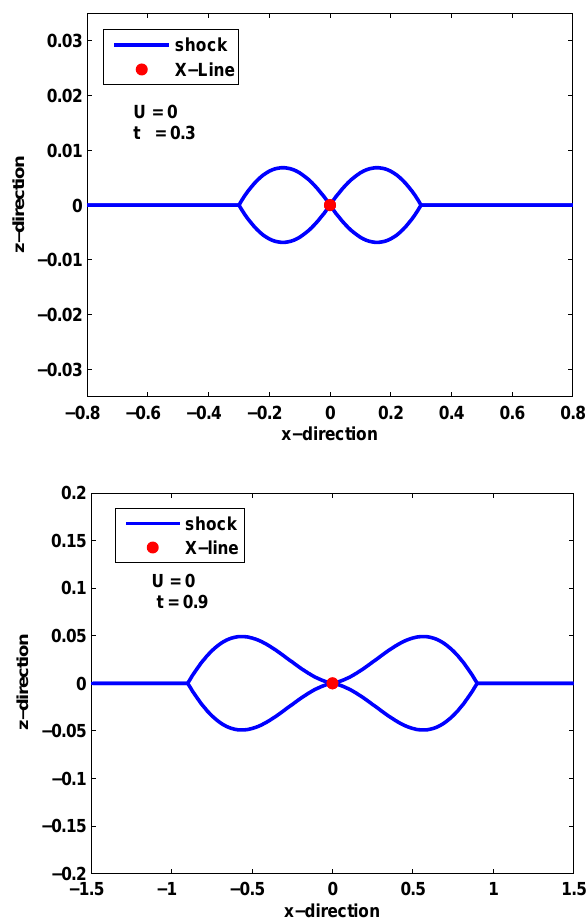
Fig. 2. Structure of the field reversal region during active recon- nection (switch-on phase) for the times t = 0 . 3 (upper panel) and t = 0 . 9 (lower panel) and velocity of the reconnection line U = 0. The reconnection line is denoted by a dot in the center, constant at x r = z r = 0. Mind the different axis scaling in the upper and lower panel.